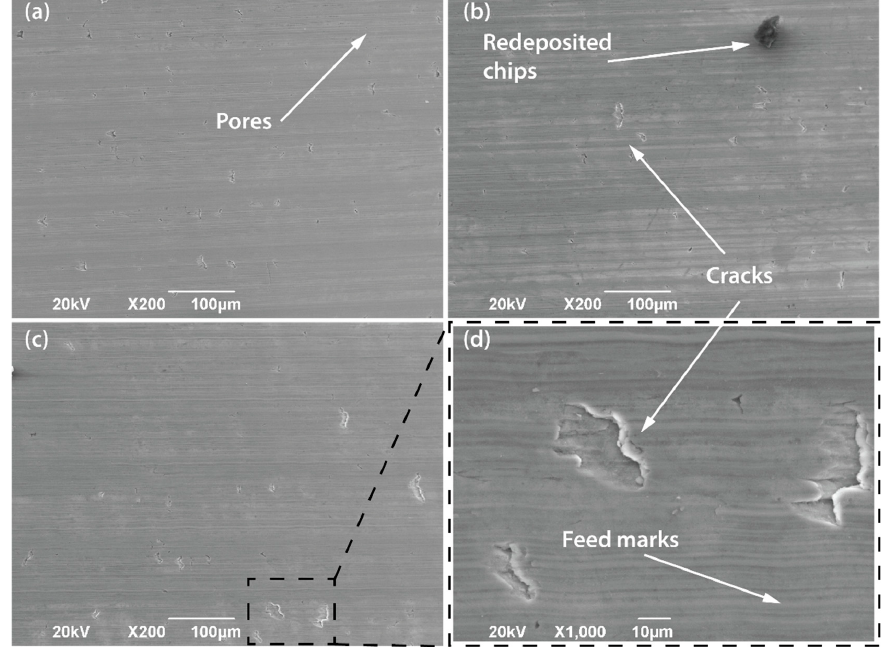
Figure 12. Morphology of the workpieces machined by using the uncoated tool at a cutting speed of 50 m/min: ( a ) configuration 1; ( b ) configuration 2; ( c ) configuration 3; and ( d ) detail of the cracks induced by machining for configuration 3. induced by machining for configuration